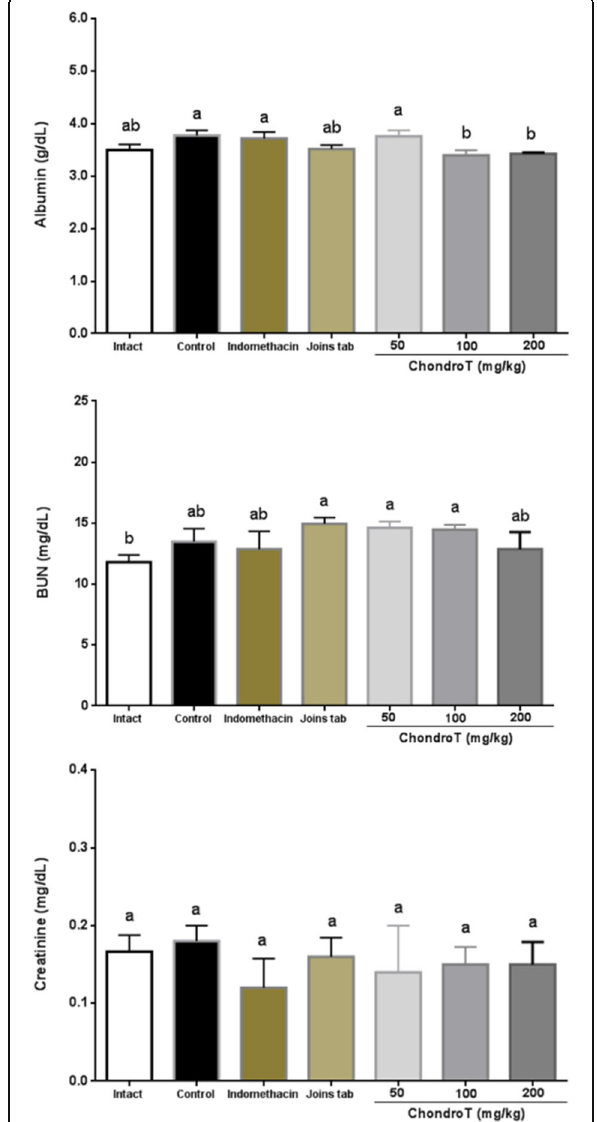
Table 6 Changes in serum albumin, BUN, and creatinine content after ChondroT administration in collagenase-induced arthritis rats